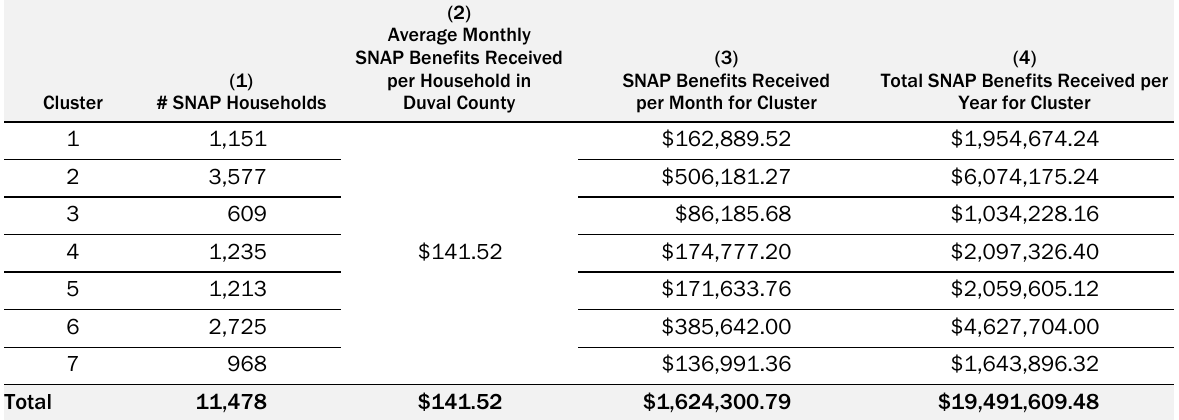
Table 3. Estimated SNAP Benefits Received per Food Desert Cluster Identified in Duval County, Florida, Using Data from the 2008–2012 American Community Survey and the Supplemental Nutrition Assistance Program Data System by Multiplying the Product (Column 4) of the Average Monthly SNAP Benefits Received per Household in Duval County (Column 3) and the Number of SNAP Households (Column 2) by 12 Months (all in